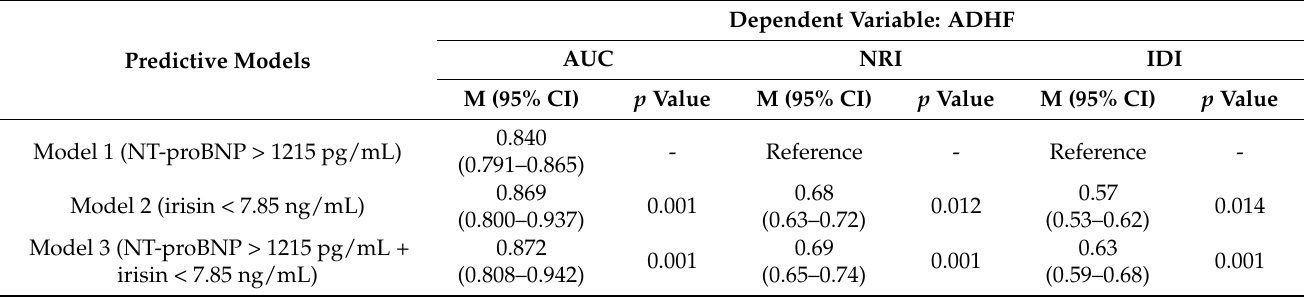
Table 4. The comparisons of predictive models for ADHF.